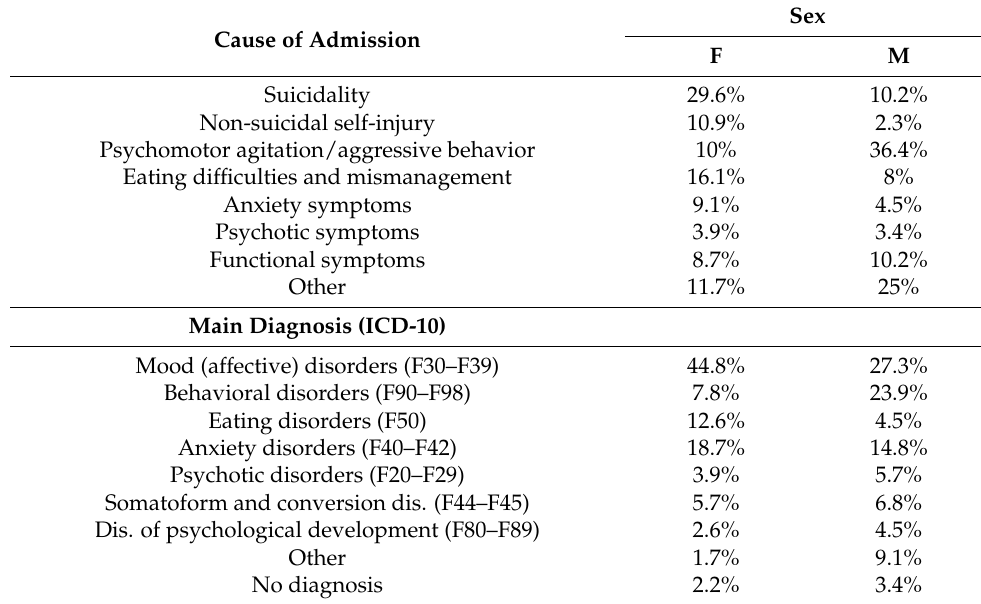
Table 5. Total percentage frequency (%) of sex for cause of admission and discharge diagnosis.